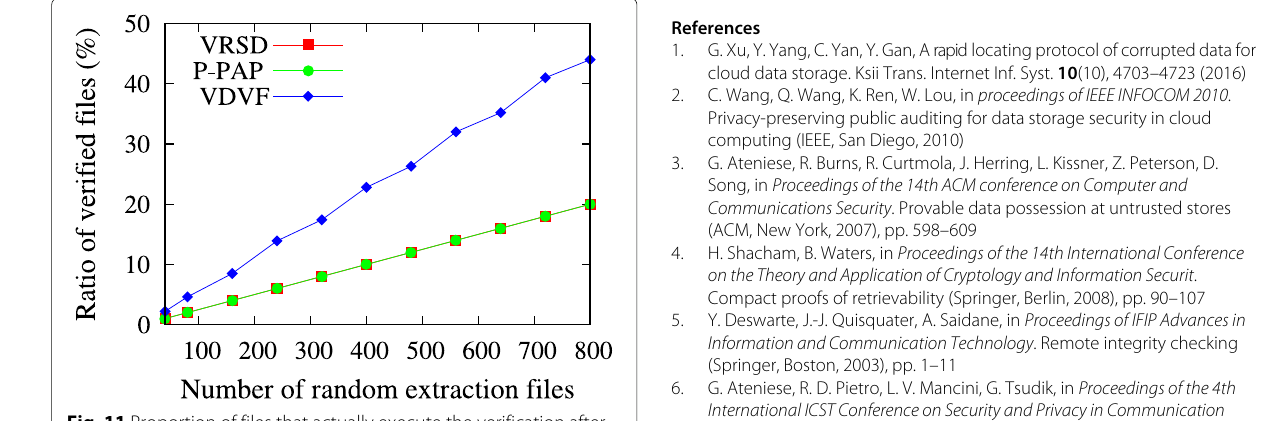
Fig. 11 Proportion of files that actually execute the verification after random